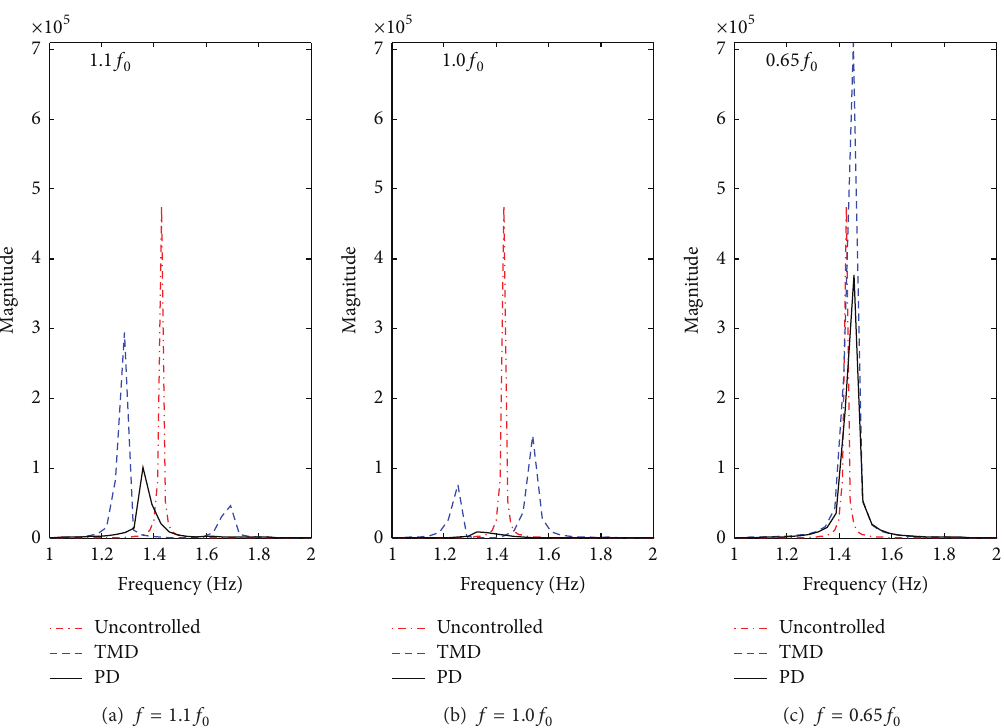
Figure 2: Frequency response of the acceleration time history of the primary structure, 𝜇 = 5